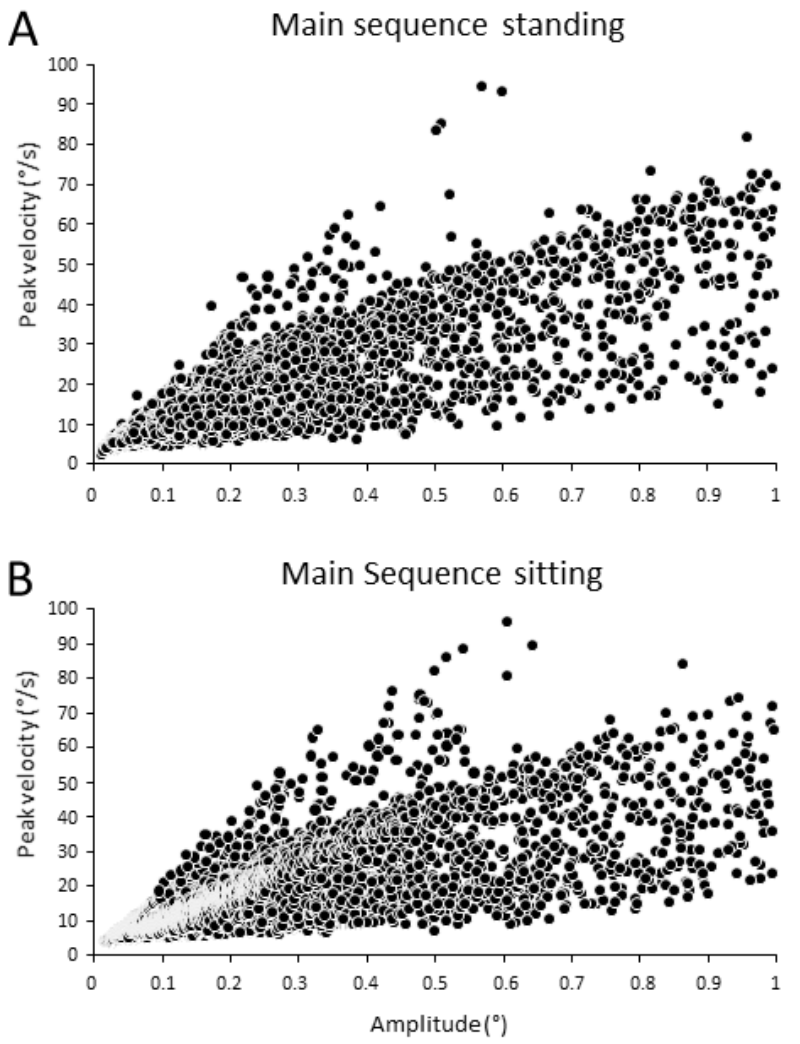
Figure 4. Microsaccade main sequence. ( A ) Main sequence when subjects were standing. Total number of microsaccades: number of microsaccades: 12,078. ( B ) Main sequence when subjects were seated. Total number of 12,078. ( B ) Main sequence when subjects were seated. Total number of microsaccades: 13,938. microsaccades: